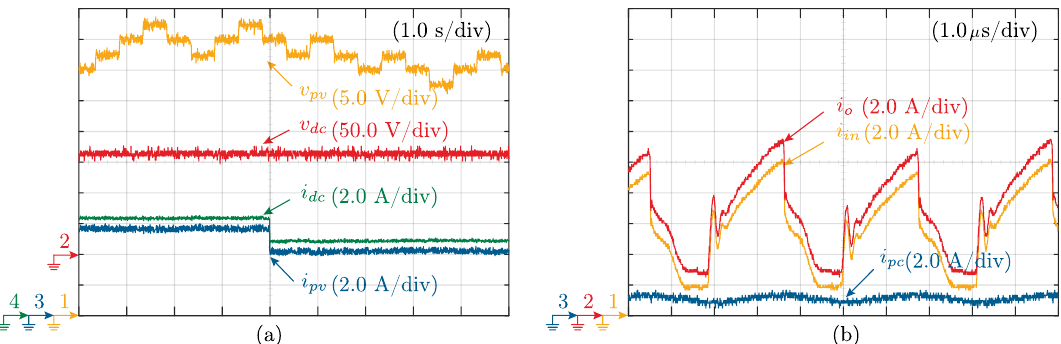
Figure 10. Experimental results under a solar irradiation reduction. ( a ) Voltage and current waveforms; ( b ) Current waveforms in the step-down Full-bridge based PPC.